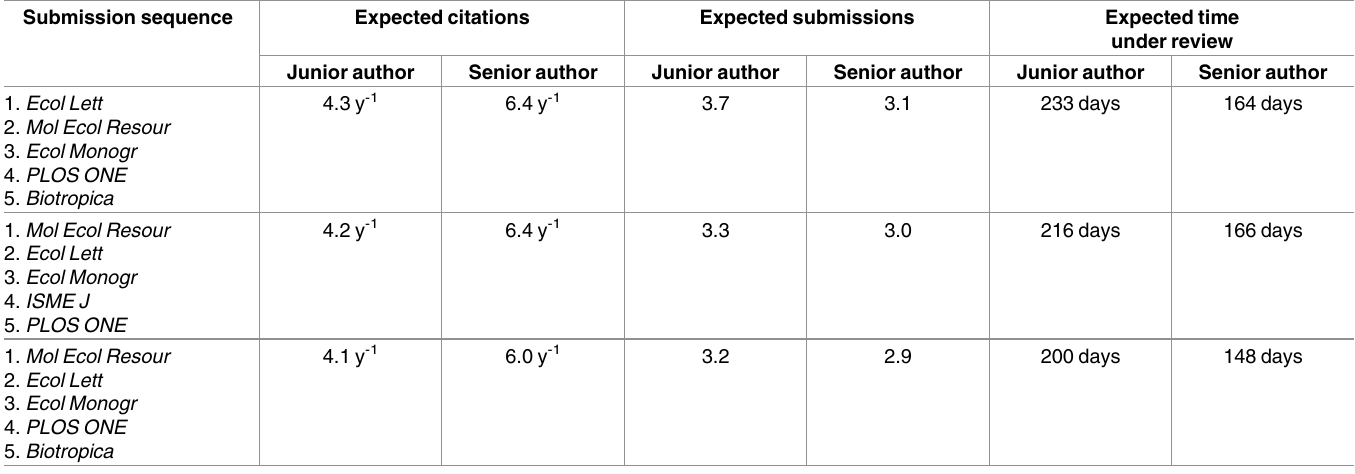
Table 2. Solutions that are Pareto-approximate for two authors. Submission